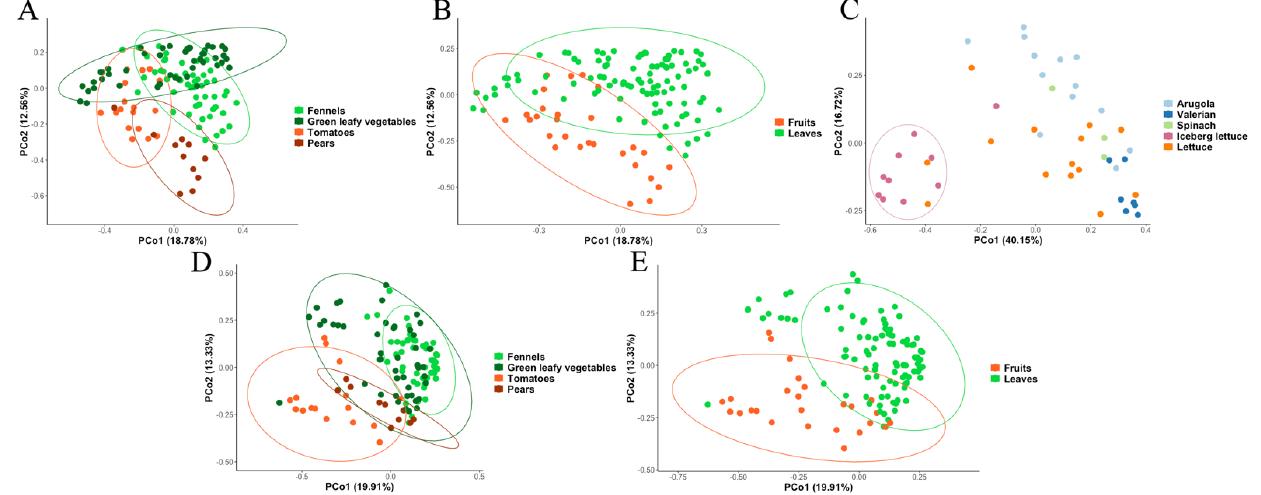
Figure 3. PCoAs based on Bray–Curtis distances matrices obtained from bacterial ( A – C ) and fungal ( D , E ) taxonomic profiles. Samples are colored according to the types of F&V ( A , D ) and the type of edible part (fruits or leaves; B , E ). ( C ) PcoA including only green-leafy vegetable samples, colored according to the vegetable species.